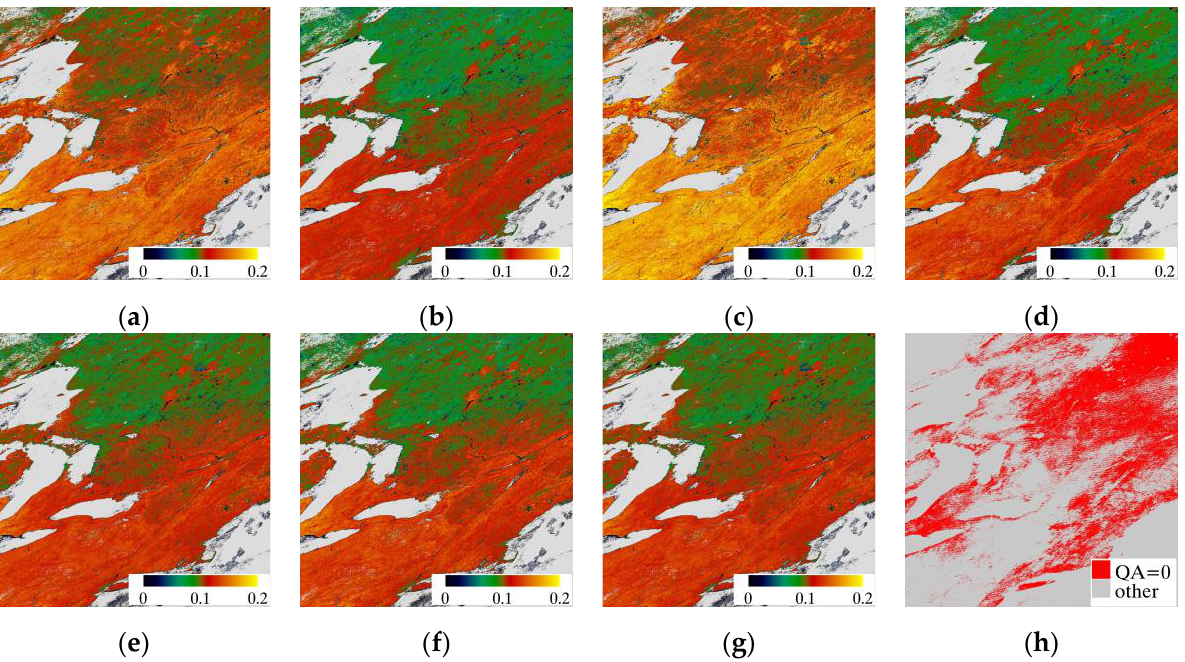
Figure 14. The simulated directional reflectance in nadir ( a ), forward angle of 30° ( b ) and backward angle of 30° ( c ) in the principal plane (PP), and the MODIS albedo product ( d ). ( e − g ) are the simulated albedo based on F and the directional reflectance of ( a − c ), and ( h ) refers to the MODIS BRDF quality-assurance (QA) product.